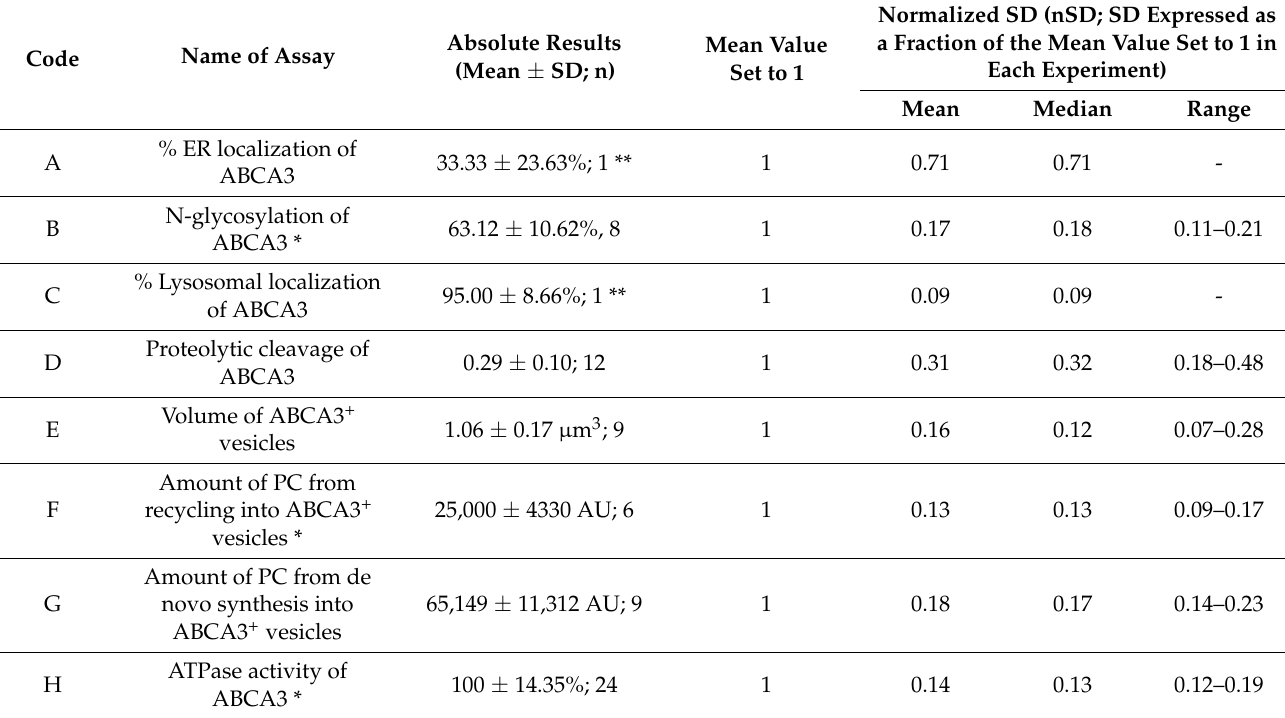
Table 1. Reference values for the various assays obtained in WT ABCA3 transfected cells without